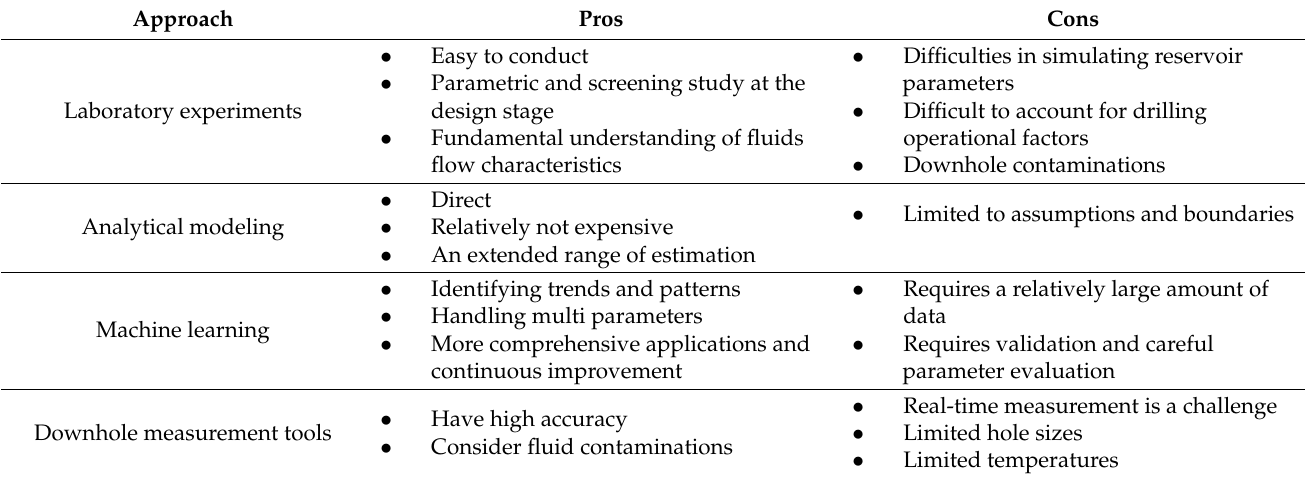
Table 1. Cons and pros for the used rheology determination